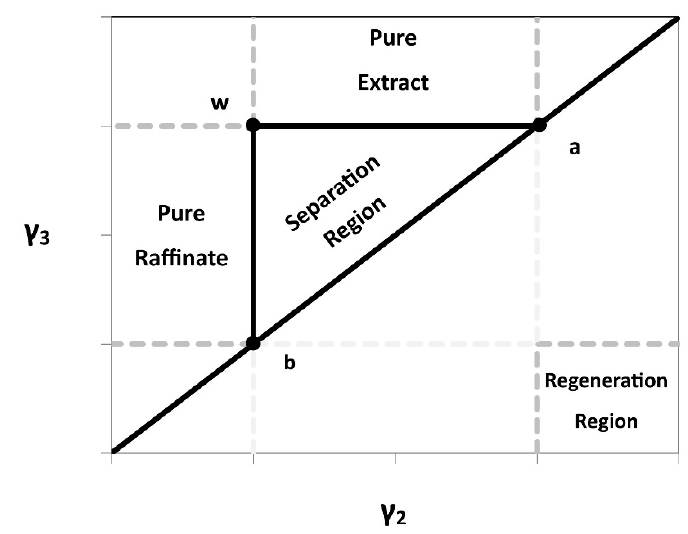
Figure 8. Separation region for linear isotherms assuming the equilibrium theory is valid.